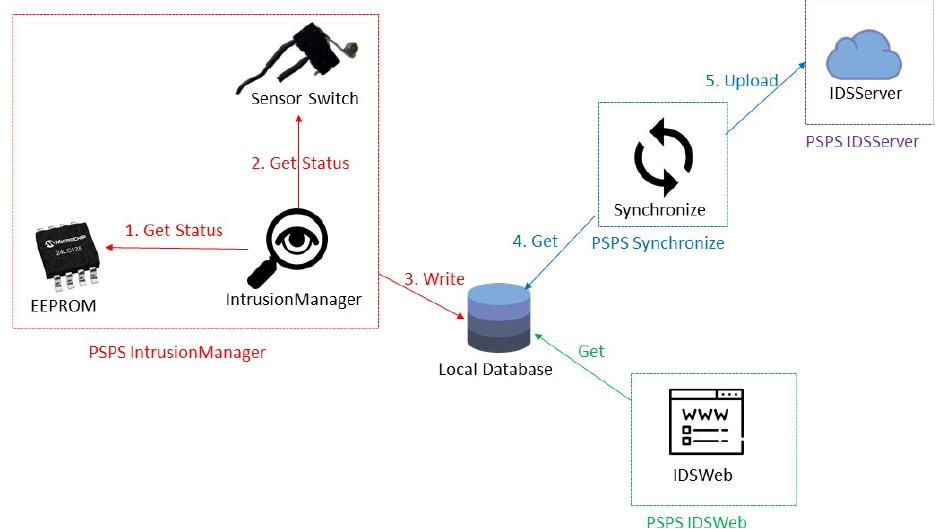
Figure 20. System operating: PSPS IDSServer is a cloud server. It can receive the sensor status and